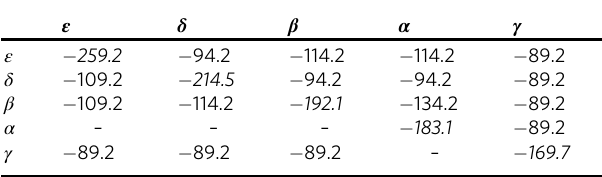
The entries in the lower left are the lowest energy lid at which transitions are found in the simulations in P 2 1 / c and P 1. Energies in italics along the diagonal are the calculated lattice energies of the four structures. All energies are in kJmol − 1